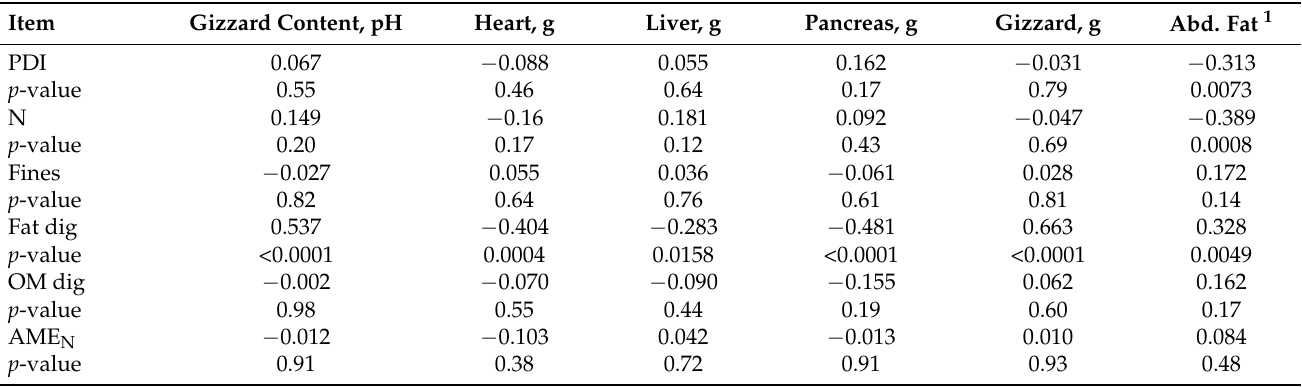
Table 17. Pearson’s correlations between feed physical proprieties and internal organs weight relative to live body weight and gizzard content pH and abdominal fat of broilers slaughtered at 36 and 37 days of age,